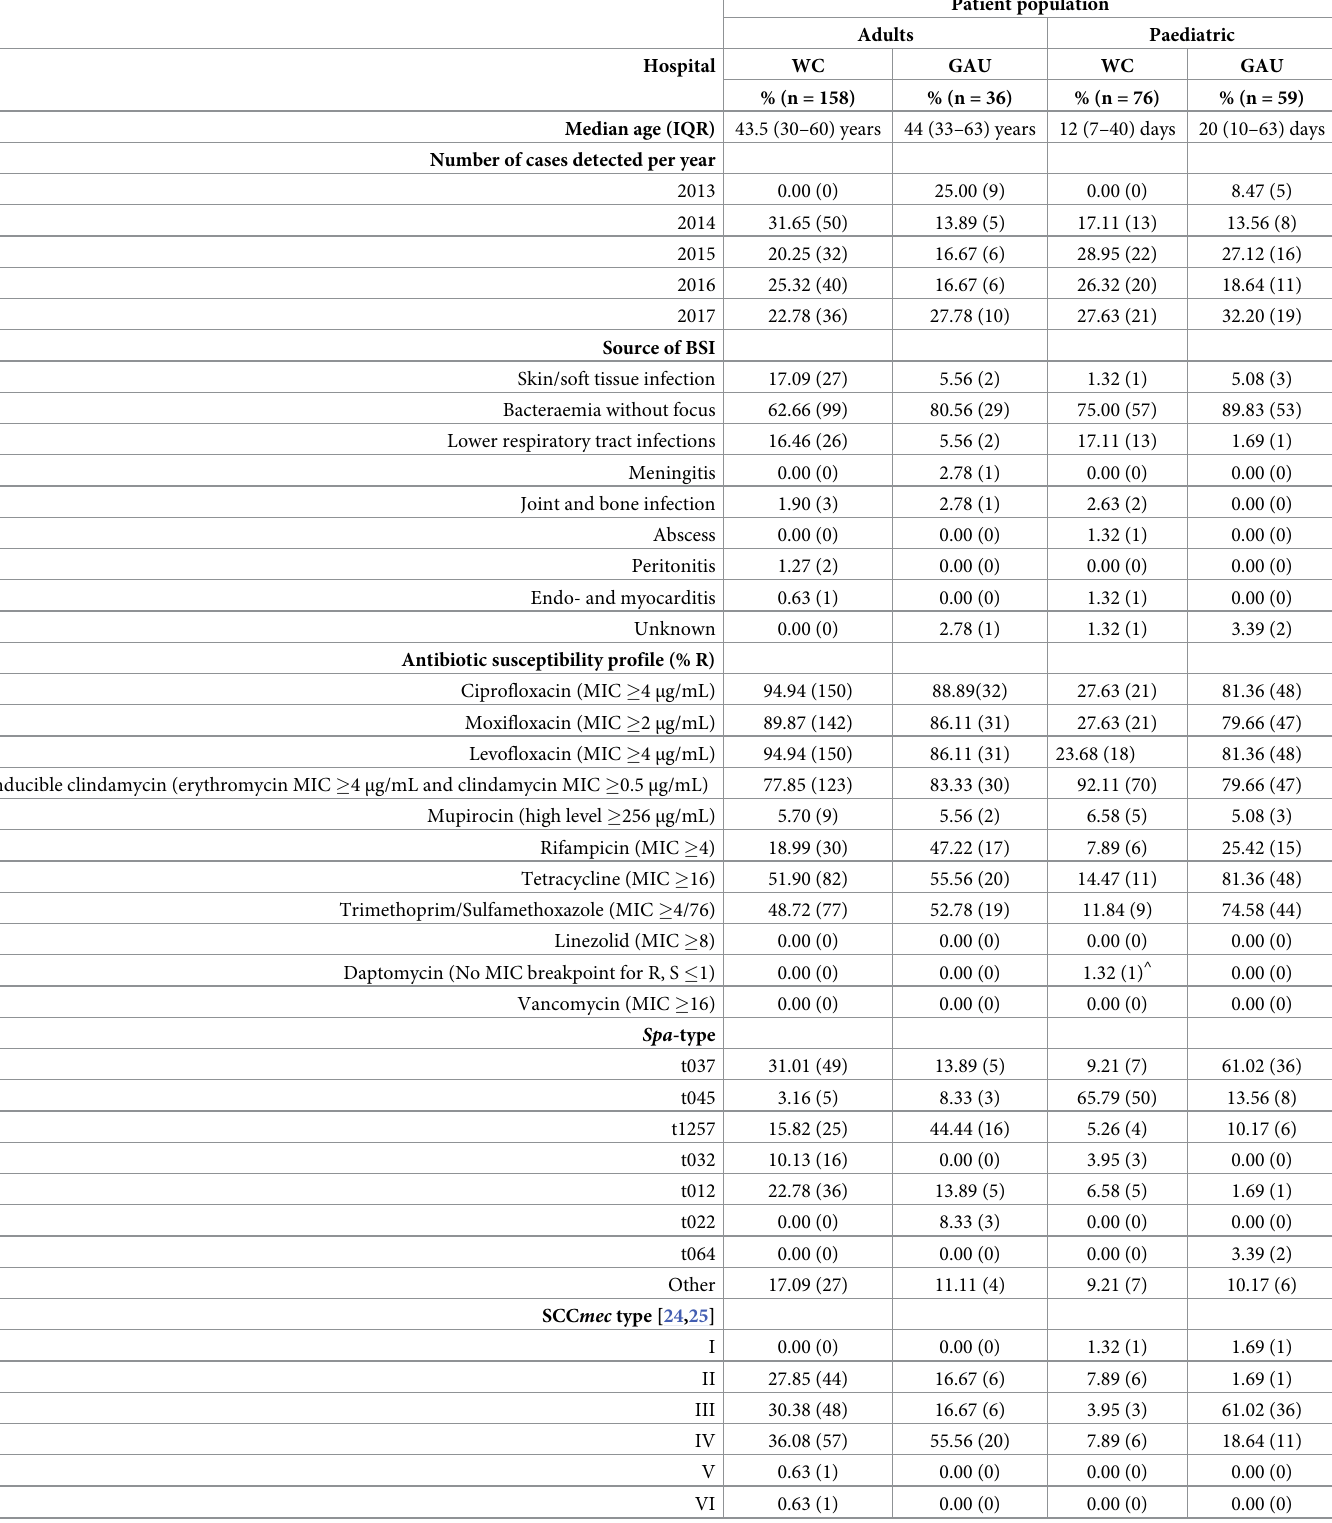
Table 1. Comparison of HA-MRSA isolates from a tertiary academic hospital in the Gauteng and the Western Cape provinces (2013 to